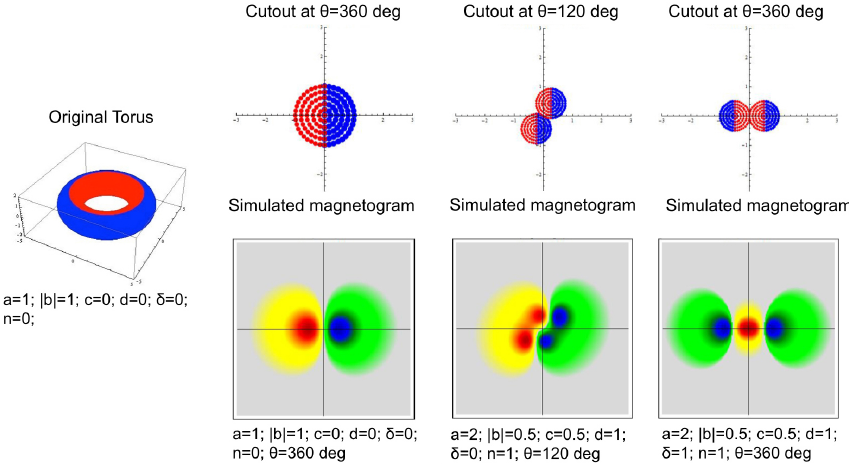
Figure 5. The most simple simulated magnetogram is obtained by taking a cut of the original torus into two equal semicircles (treated as positive and negative poles) and a grid of values is calculated based on their inverse distance squared to the semicircles. We may then e.g. map the torus once ( n = 1), and take cuts at θ = 120 ◦ or θ = 360 ◦ and obtain the other magnetograms.